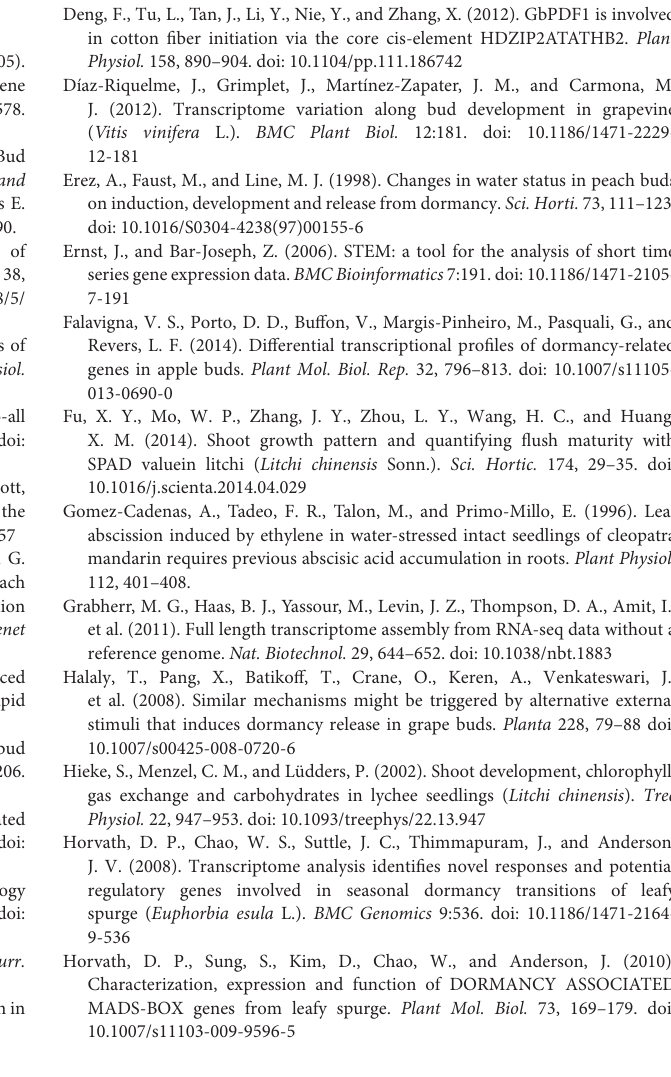
Figure S1 | Procedures of sample process for RNA sequencing (A), de novo assembly (B), unigene annotation and global gene expression analyses (C). Figure S2 | GO (A) and COG (B) functional classification of all unigenes. Figure S3 | The 26 gene expression profiles subject to STEM analysis. Colored profiles are significant with P < 0.01. Figure S4 | Hormone signal pathways in litchi buds. Components in red frames were up-regulated during growth cessation and dormancy (Profiles 5 and 2 in Table 7 ). Table S1 | Unigenes and their primer pairs for real-time PCR. Table S2 | PC1 and PC2 scores of all